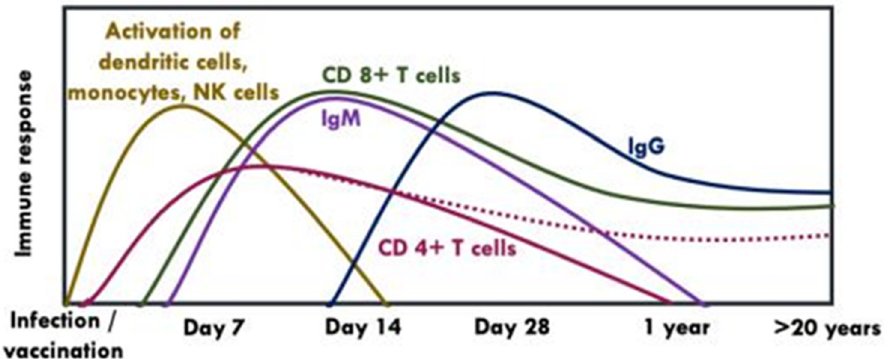
Figure 5. Kinetics of humoral and cellular immune response following vaccination with YFV-17D [38,39,41–43]. NK: Natural killer cells. The dotted line indicates that CD 4+ T cells may be present or absent in some individuals after years post-vaccination.